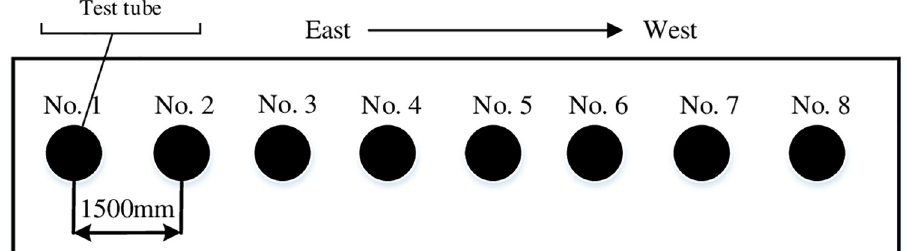
Fig 10. Schematic layout of test tube